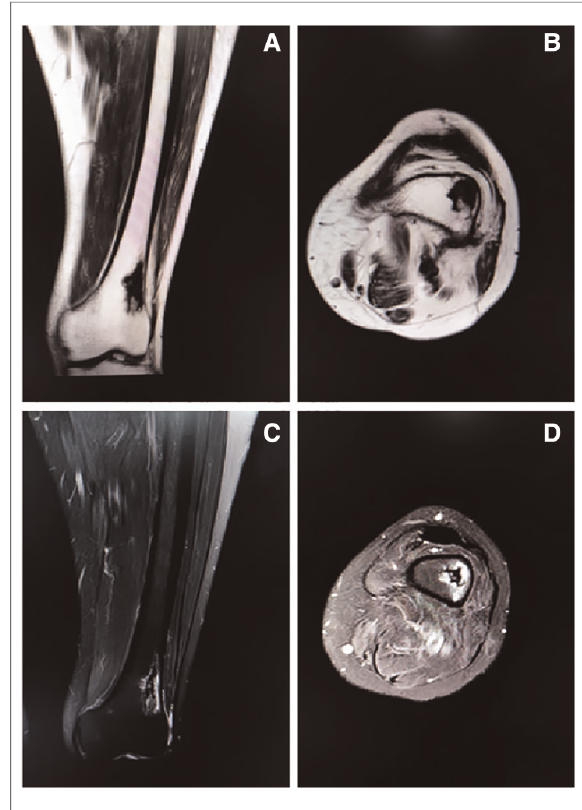
FIGURE 2 Representative coronal ( Figure 2A ) and axial ( Figure 2B ) T1-weighted images showing an isolated patchy abnormal signal of the left distal femur, with low signal intensity. Representative coronal ( Figure 2C ) and axial ( Figure 2D ) T2-weighted images showing a heterogenous lesion of the left distal femur with high signal intensity, with uneven internal signal, and no clear abnormal signal in the muscle and subcutaneous soft tissue of the left